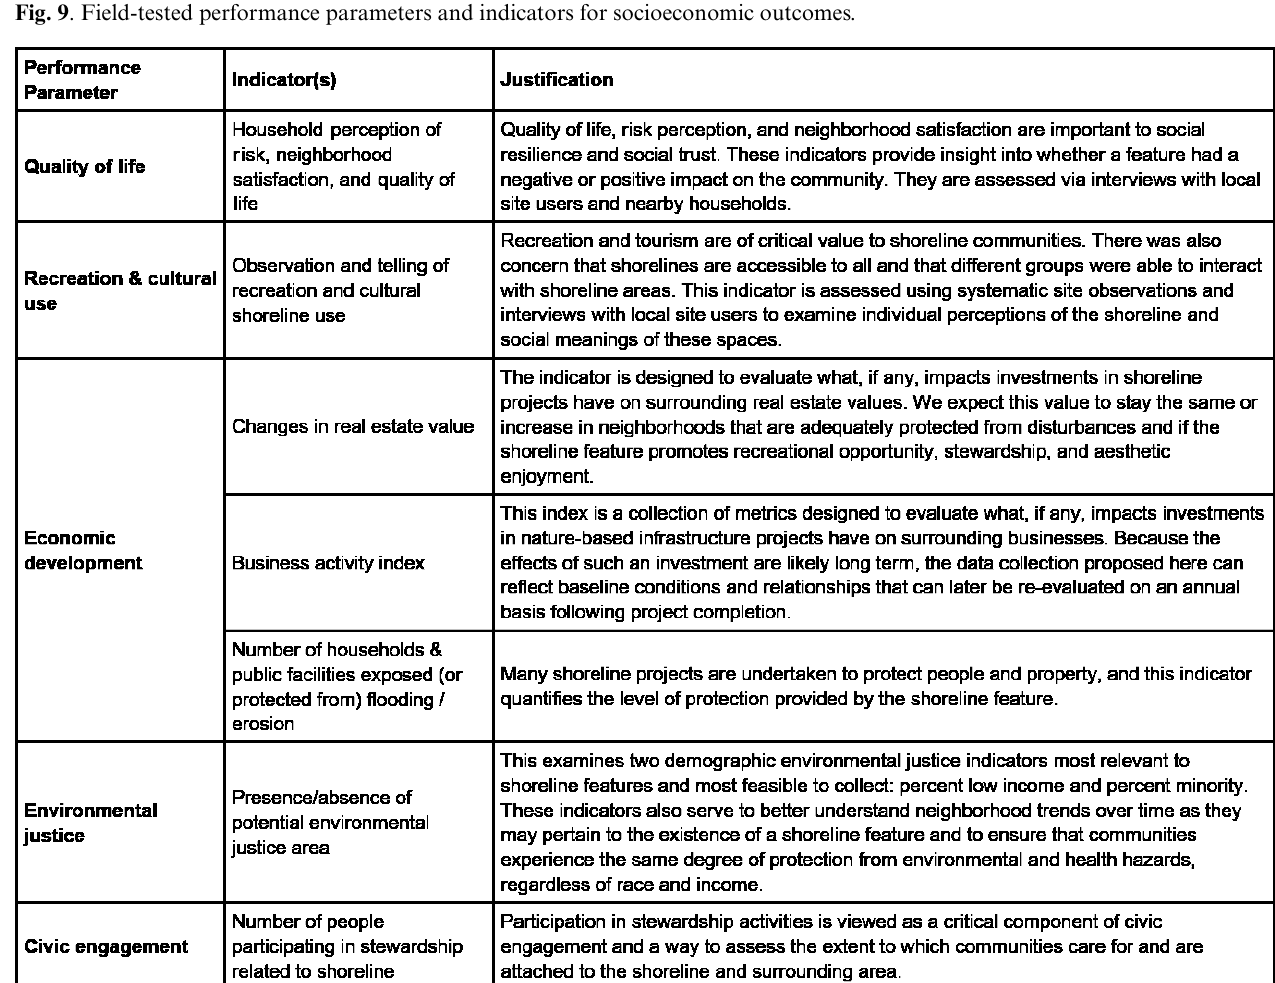
Fig. 9 . Field-tested performance parameters and indicators for socioeconomic